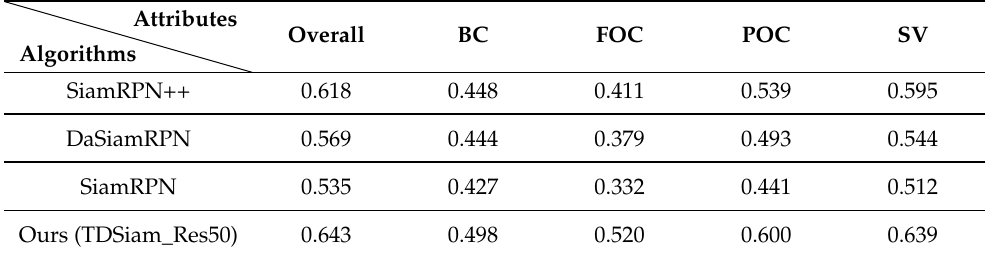
Table 1. Comparisons of the success rate between the proposed approach and the existing approaches including SiamRPN++, DaSiamRPN and SiamRPN on the UAV123 dataset.